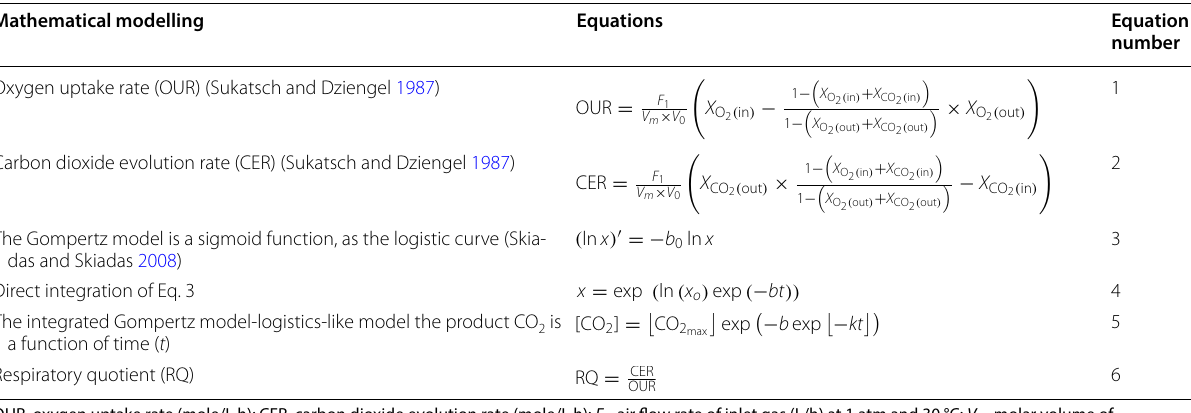
Table 2 Equations used for simulation data from respiratory gases Mathematical modelling Equations Equation